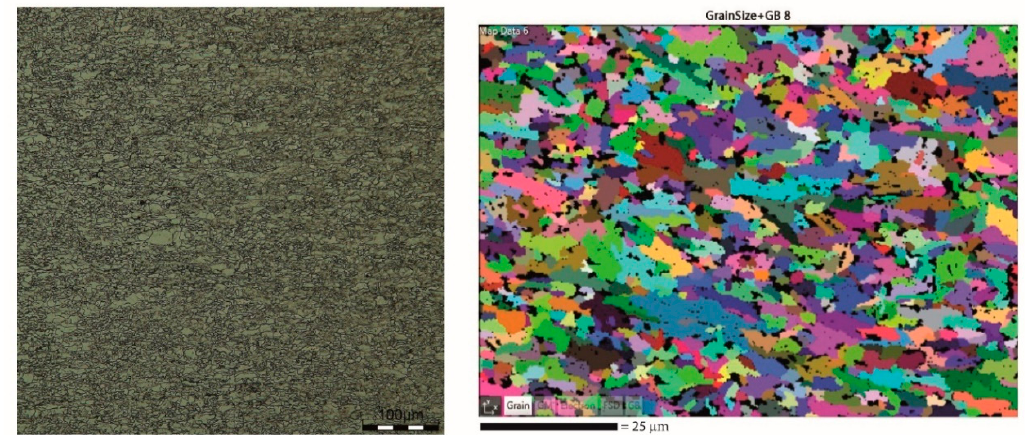
Figure 1. Ferritic-bainitic structure ( left ) and EBSD grain size analysis ( right ) of tested S700MC steel.